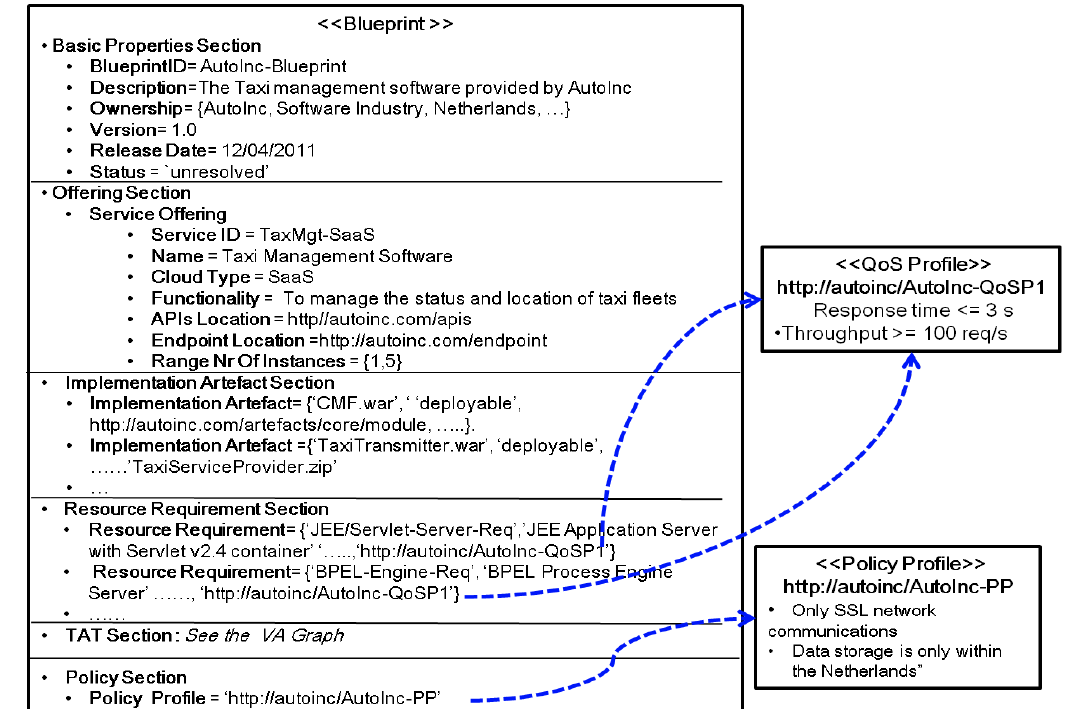
Figure 5. Example of using the Blueprint